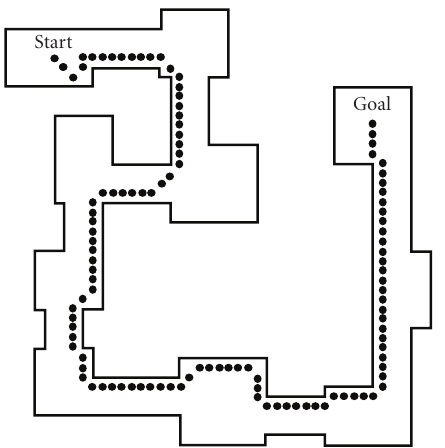
Figure 4: Stealthy pathfinding for trial 18 and γ = 10%.